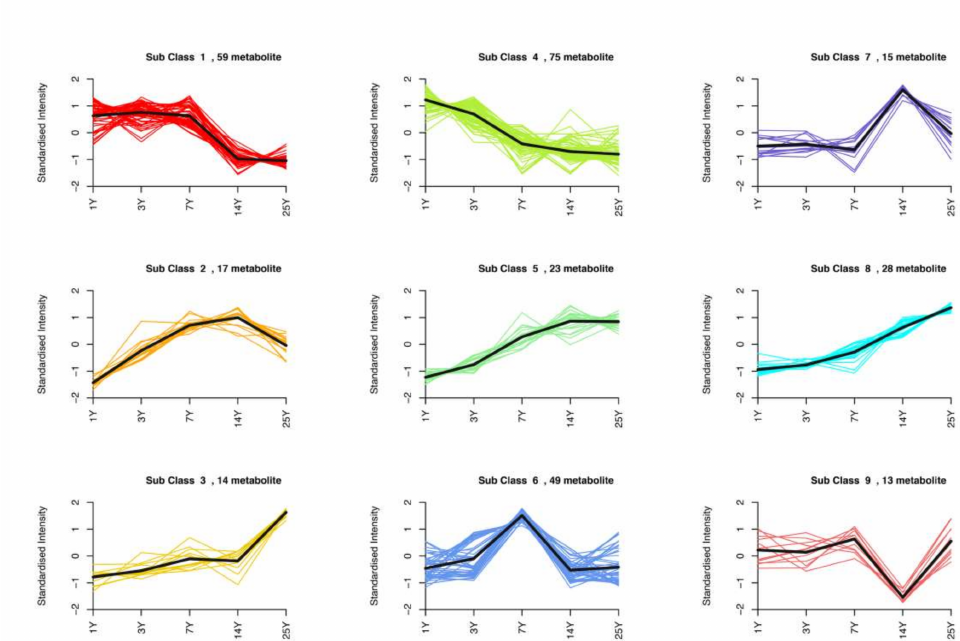
Figure 4. A total of 293 differential metabolites were classified into nine types by K-means clus- tering (K-means) analysis, based on the variation tendency along with the extent of storage time. The X-axis represents the sample groups, and the Y-axis represents the relative content of metabo- lites standardized. Subclass represents different change tendencies and the number of metabolites under